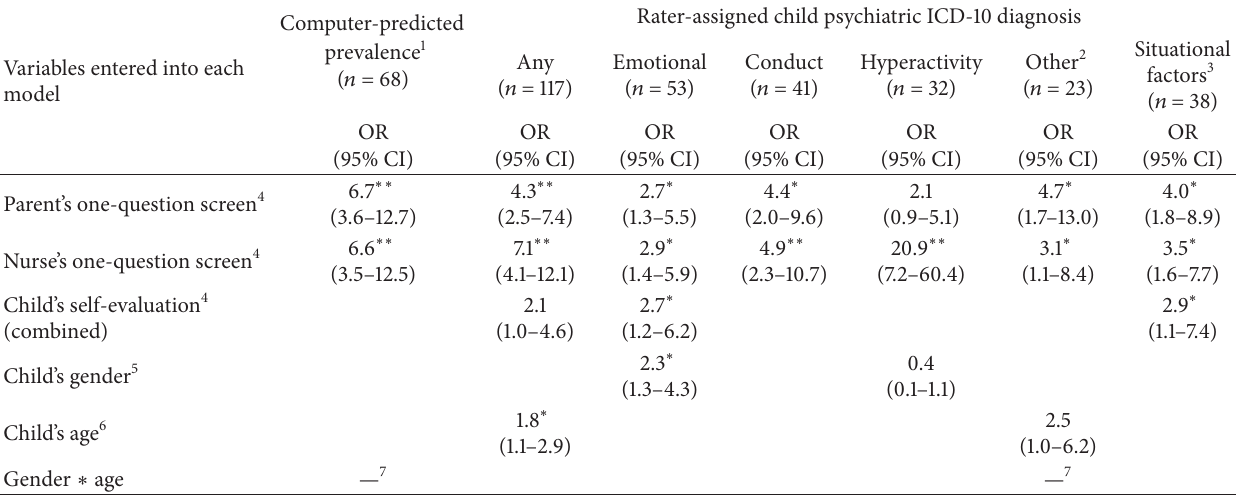
Table 4: The odds ratios (OR) for child outcomes related to the combined effects of the parent’s and nurse’s one-question screen and the child’s self-evaluation of emotional well-being as well as child’s gender and age group. The OR for the variables remaining in the model at the last step of each backwards stepwise logistic regression are